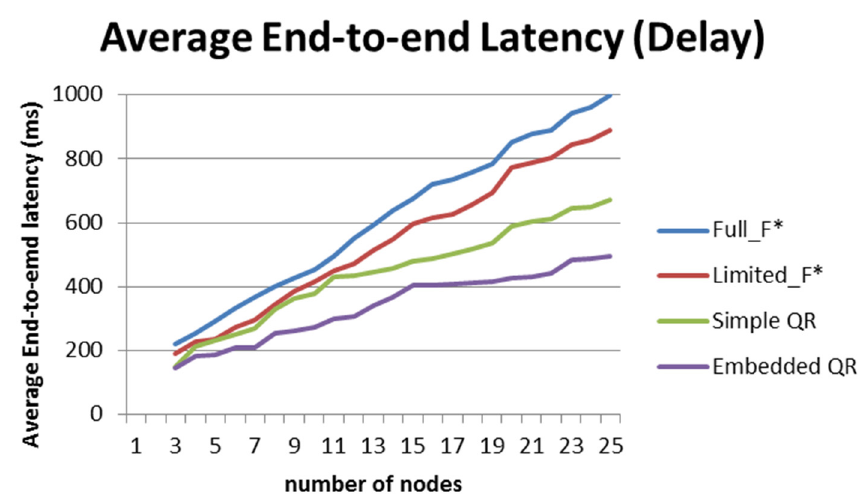
Figure 15. Comparison of end-to-end packet network delay by different communication architectures.